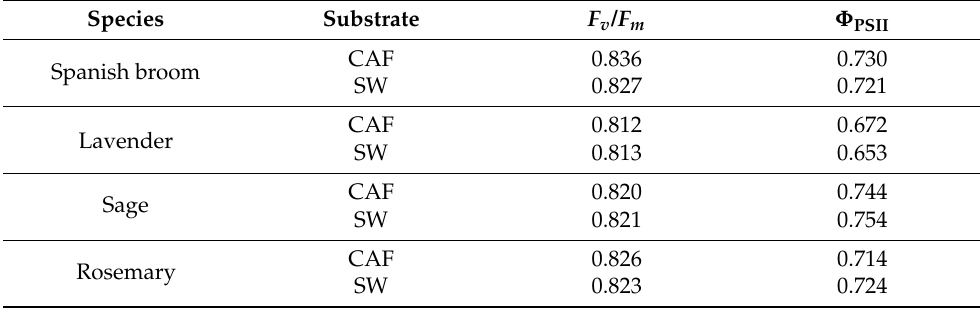
Table 3. Effect of different substrates on the chlorophyll a fluorescence in ornamental plants. Maxi- mum photochemical efficiency ( F v / F m ) and photochemical yield in the light ( Φ PSII ) of photosystem II (PSII) were assessed in leaves of 8 week-old plantlets of Spanish broom and lavender or 12 week- old cuttings of sage and rosemary grown in recycled cellulose acetate filters (CAF) or stone wool (SW) substrates. Data are means of 3 different